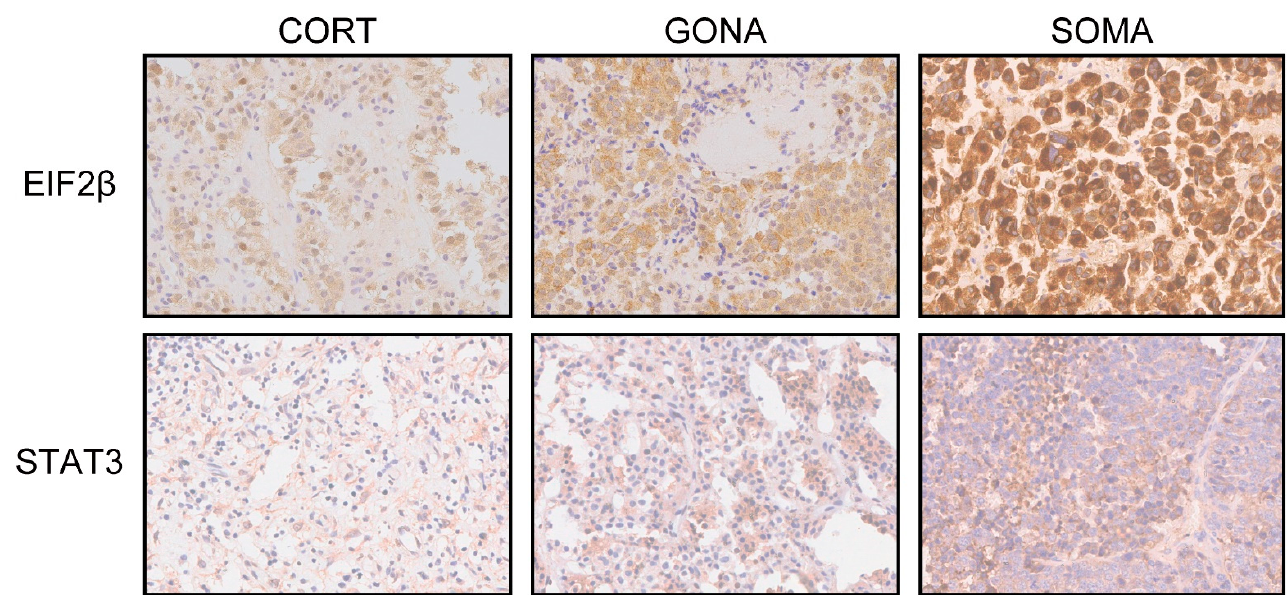
Figure 2. Immunohistochemistry images of EIF2 β and STAT3 in corticotroph adenomas, gonadotroph adenomas, and somatotroph adenomas. CORT: corticotroph adenomas; GONA: gonadotroph adenomas; SOMA: somatotroph adenomas (×: 40 fold).